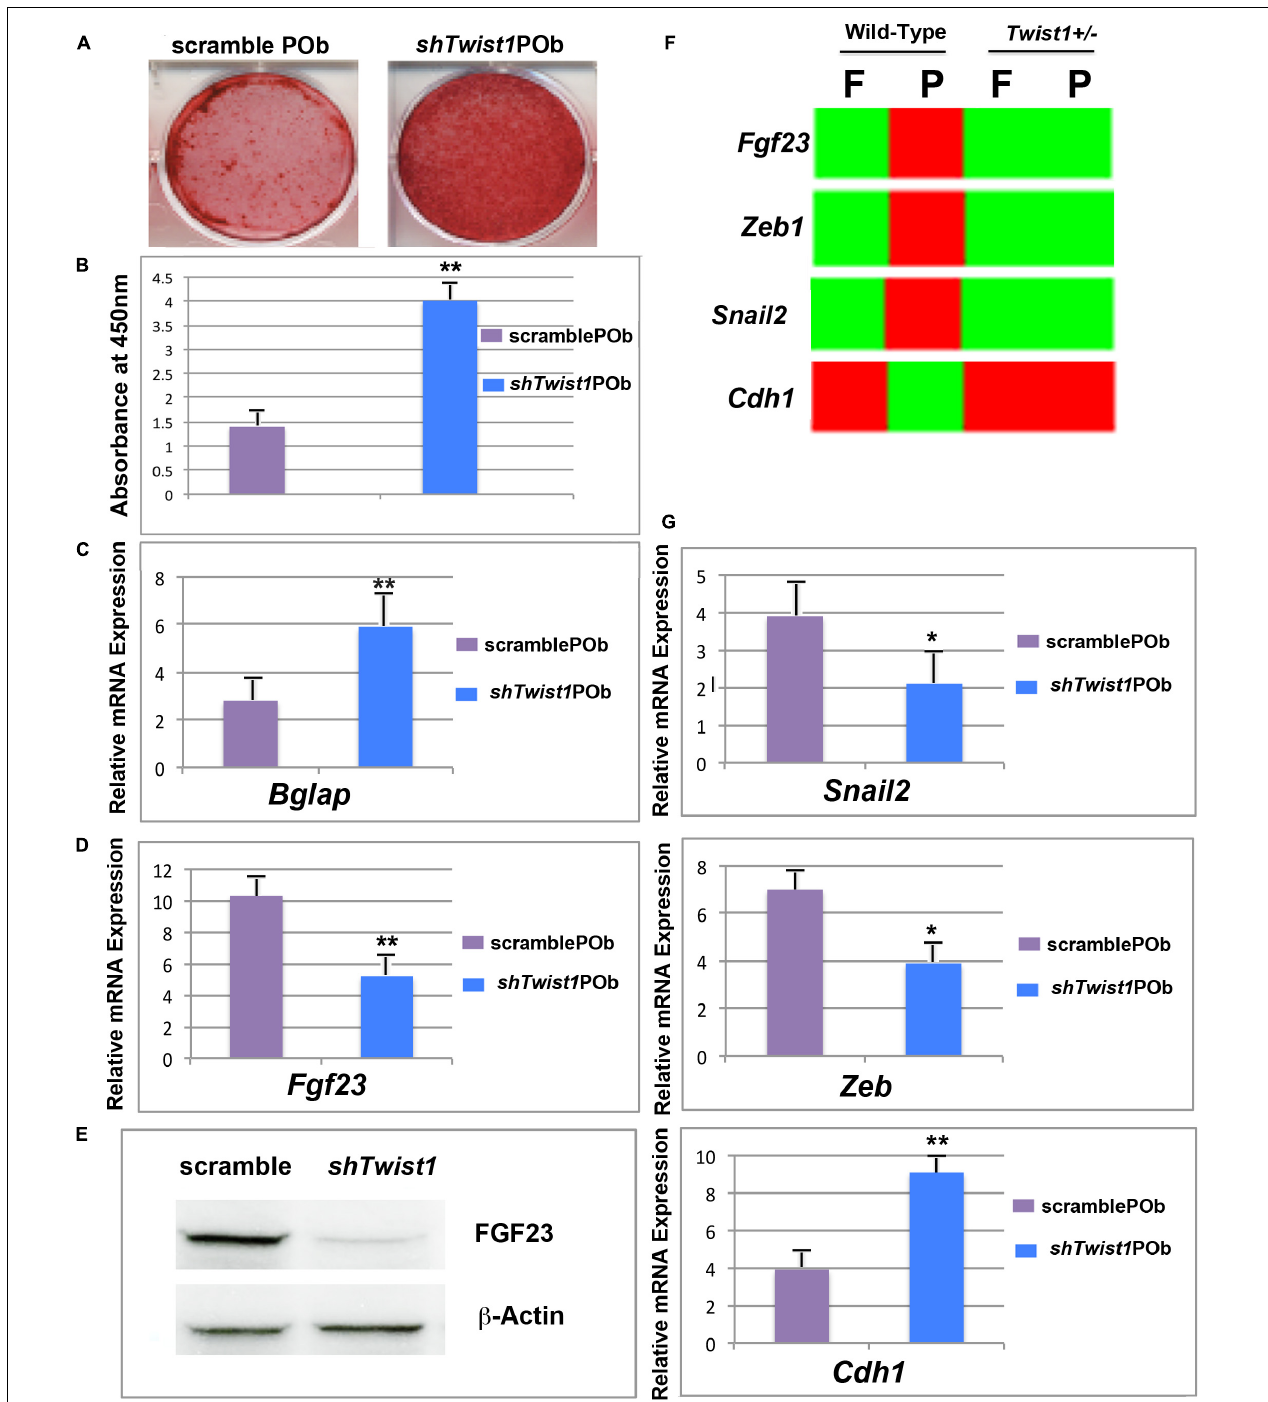
FIGURE 6 | Twist1 silencing phenocopies the osteoskeletal profile of Twist1 haploinsufficiency in POb by downregulating Fgf23 . (A) Osteogenic differentiation assay performed on sh Twist1 POb revealed a robust extracellular matrix mineralization. (B) Quantification of Alizarin red staining for the osteogenic assay shown in panel A . (C) RT-qPCR analysis showing significant upregulation of Bglap as compared to scramble POb. (D) RT-qPCR analysis performed on stable transduced cells upon puromicin selection reveals that sh-mediated Twist1 silencing triggers a significant downregulation of Fgf23 expression. (E) Immunoblotting analysis using anti-FGF23 antibody confirms decreased FGF23 at protein level in sh Twist1 POb compared to scramble POb. (F) Bulk RNA-seq analysis showing the effect of Twist1 haploinsufficiency on some of its target genes such Zeb , Snail1 , and Cdh1 and comparison in wild-type versus Twist1 haploinsufficiency parietal bones. (G) As assessed by RT-qPCR analysis a similar pattern is observed in stable transduced sh Twist1 POb and scramble POb upon puromicin selection and culturing them. Values: ∗ p ≤ 0.05, ∗∗ p ≤ 0.01.